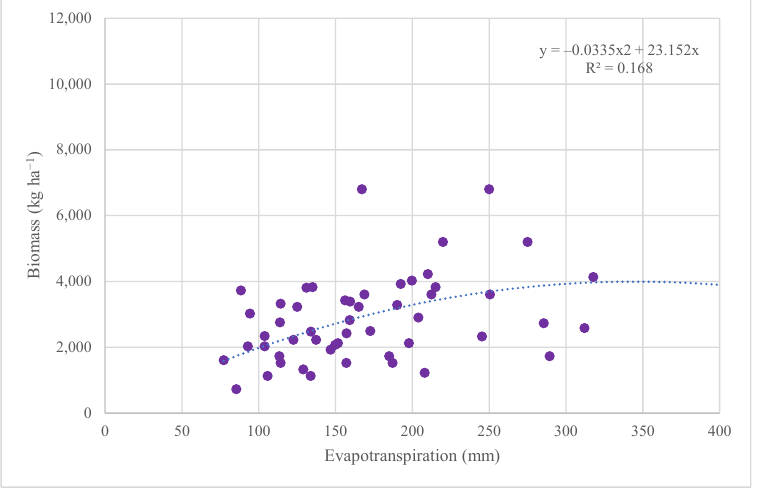
Figure 4. WPF of alfalfa relating ET c and biomass produced under deficit irrigation treatments.